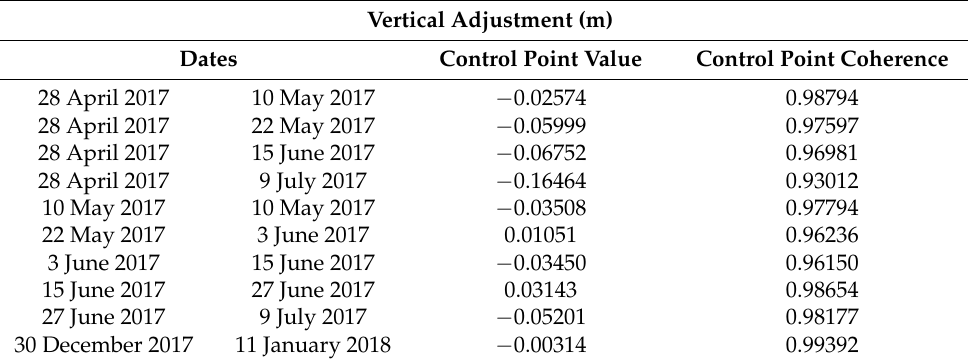
Table 2. Values of the zero-deformation control points